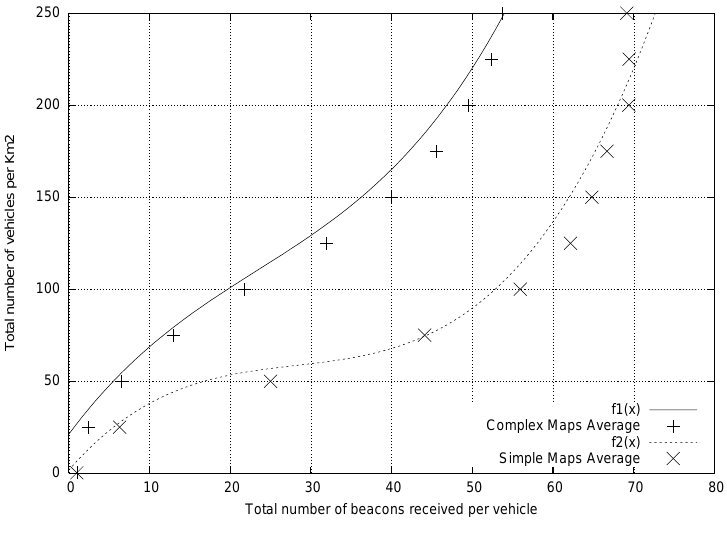
Figure 6. Comparison between simulated and estimated average results.